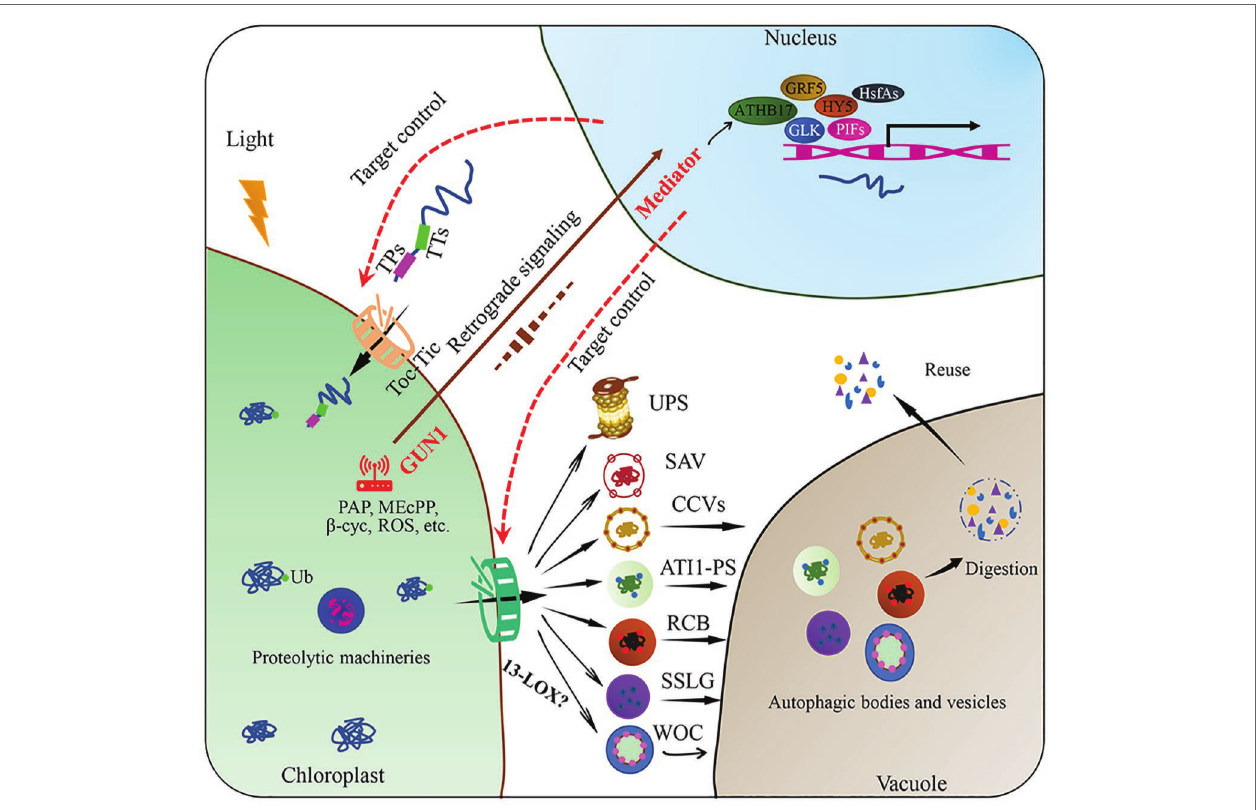
FIGURE 2 | Targeted control of plant chloroplast quality. Chloroplast proteins encoded in the nucleus are transported across the chloroplast envelope through Toc-Tic complexes. Chloroplast protein degradation through various pathways, including chloroplast protein hydrolysis and the SAVs, CCVs, ATI1-PS, RCB, SSLG, or WOC, these degraded substances can be reused within the cell after degradation. Chloroplast retrograde signaling is involved in the regulation of chloroplast proteome remodeling under fluctuating environmental conditions. Plastid metabolism includes phosphonucleotide 3 ′ -phosphoadenosine 5 ′ -phosphate (PAP), methyl erythritol (MEcPP), beta cyclocitral (beta cyc), fatty acids (FAs), and ROS. After environmental stimuli are perceived by the chloroplast, some transcription factors, such as PIFs, GLK, HY5, GRF5, HsfAs, and ATHB17, are involved. Chloroplast protein import and export are the potential targets of chloroplast quality control. Ub: ubiquitin; RCBs: RuBisCO-containing bodies; ATI1-PS: ATG8-interacting protein 1 positive bodies; SSLGs: small starch-like granule bodies; SAVs: senescence- associated vacuoles; CCVs: chloroplast vesiculation-containing vesicles; PIFs: phytochrome interaction factors; HY5: elongated hypocotyl 5; GLK: golden 2-like, ATHB17: Arabidopsis thaliana homeobox17, GRF5: growth retardation factor 5; HsfAs: heat stress transcription